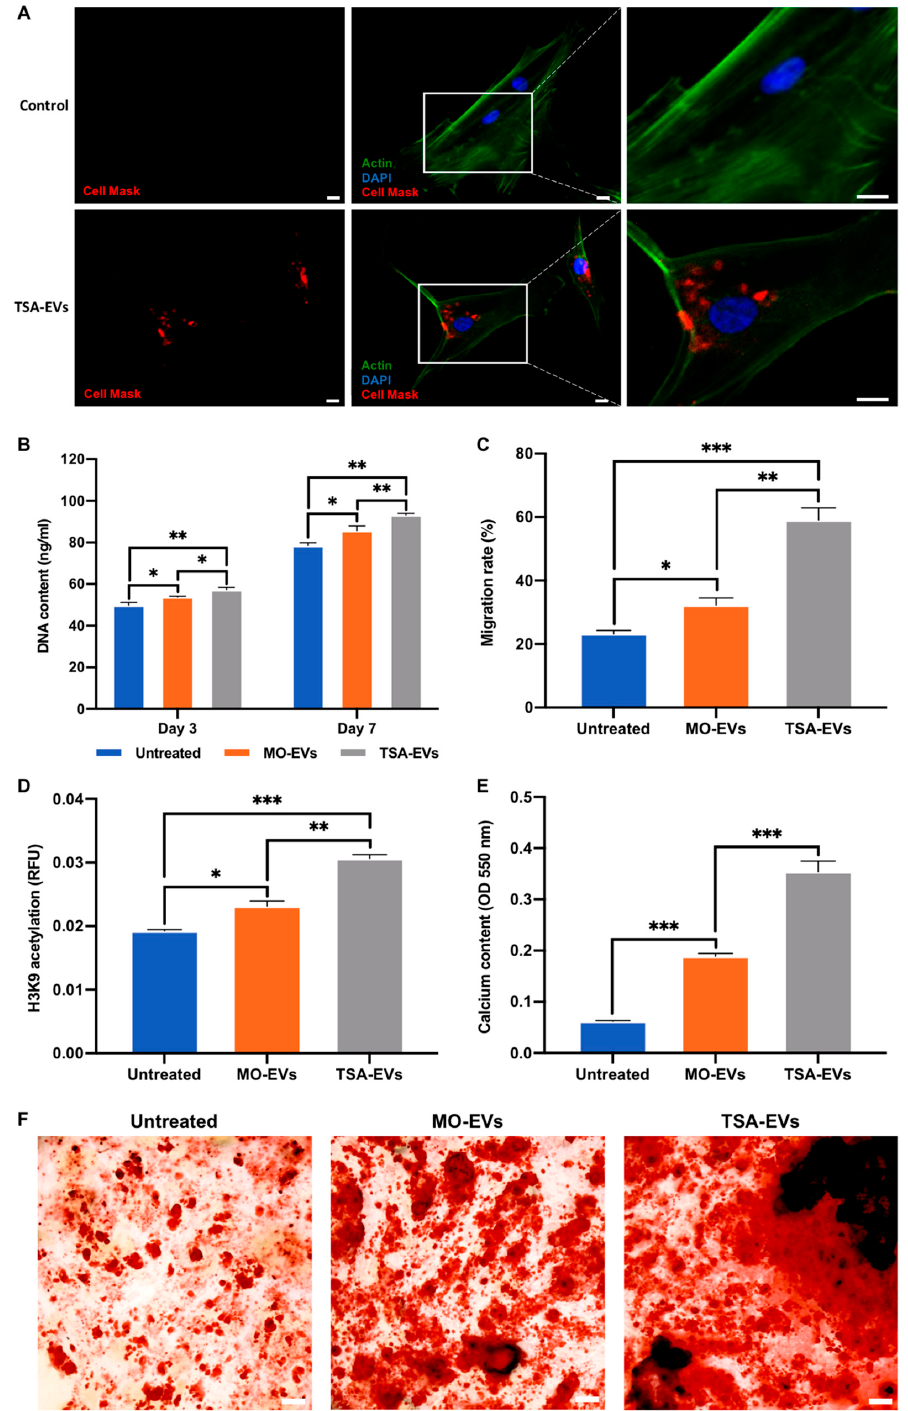
Figure 5. The biological efficacy of hydrogel-released EVs on hBMSCs behaviour. The influence on hydrogel-released EVs on hBMSCs ( A ) EV uptake (Scale bar = 20 µm), ( B ) proliferation, ( C ) migration, ( D ) H3K9 acetylation levels, ( F ) collagen production and ( E , F ) calcium deposition. Black staining indicates mineral nodules. Scale bar = 100 µm. Data are expressed as mean ± SD ( n = 3). * p ≤ 0.05, ** p ≤ 0.01 and *** p ≤ 0.001.